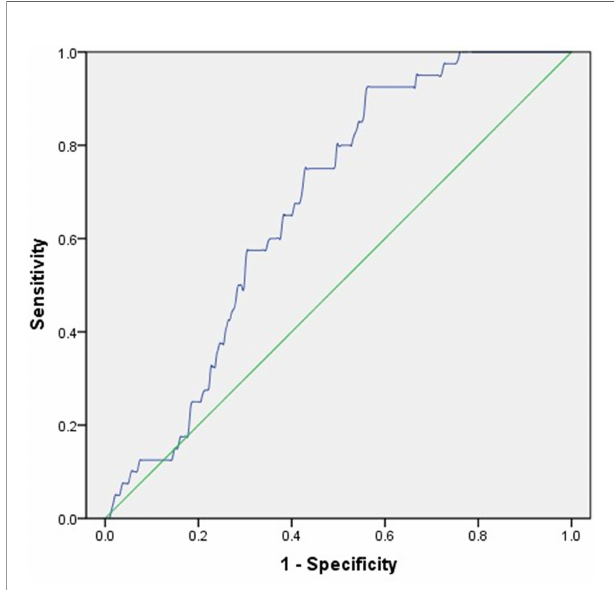
FIGURE 1 | ROC analysis employed to identify the optimal cut-off value of MAGE to predict osteoporosis in T2DM patients. AUC (95% CI) = 0.673